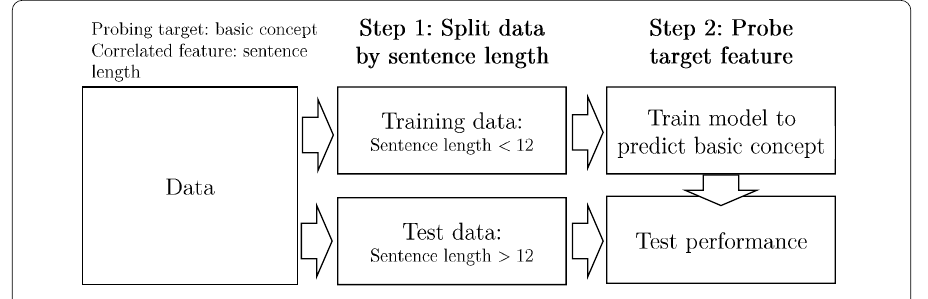
Figure 1 Illustration of Train-test Splitting for the Probing Analysis. Note that in this figure, the probing target is basic concept, while the correlated feature is sentence length